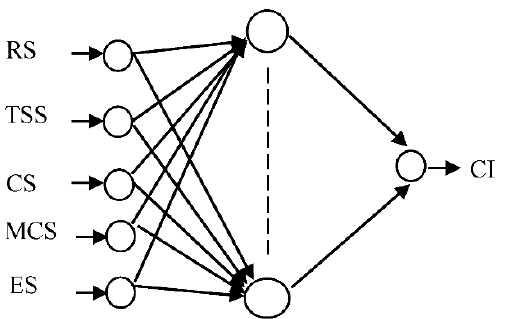
Figure 9. The architecture of ANN is used for STPP. Table 9. Statistical values of main simulated architectures.